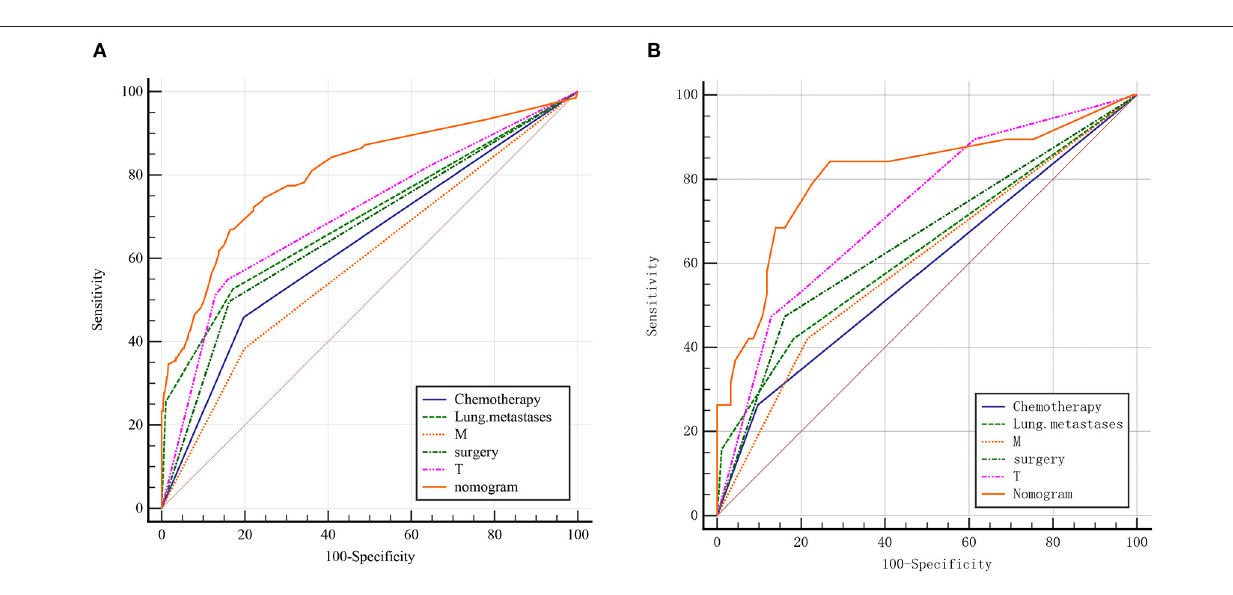
FIGURE 2 | ROC curves for the training and validation group. (A) training group; (B) validation group.